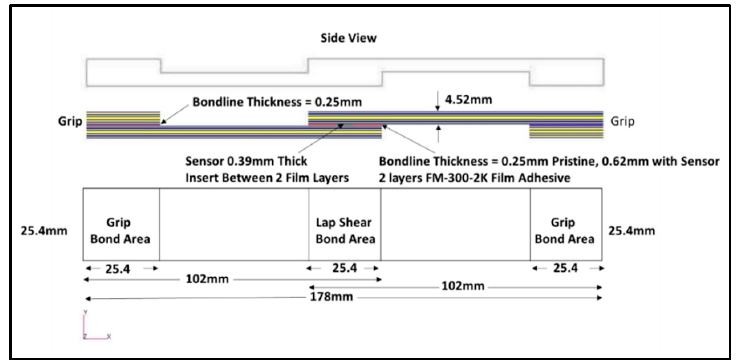
Figure 9. Lap shear test coupon dimensions.